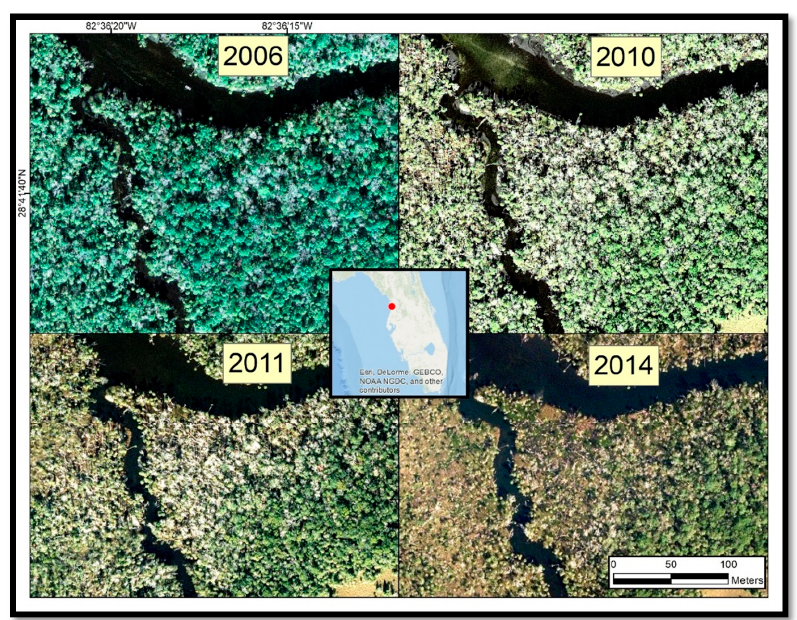
Figure 4. Figure 4. Aerial photographs from 2006, 2010, 2011, and 2014 of a tributary along the Chassahowitzka River.